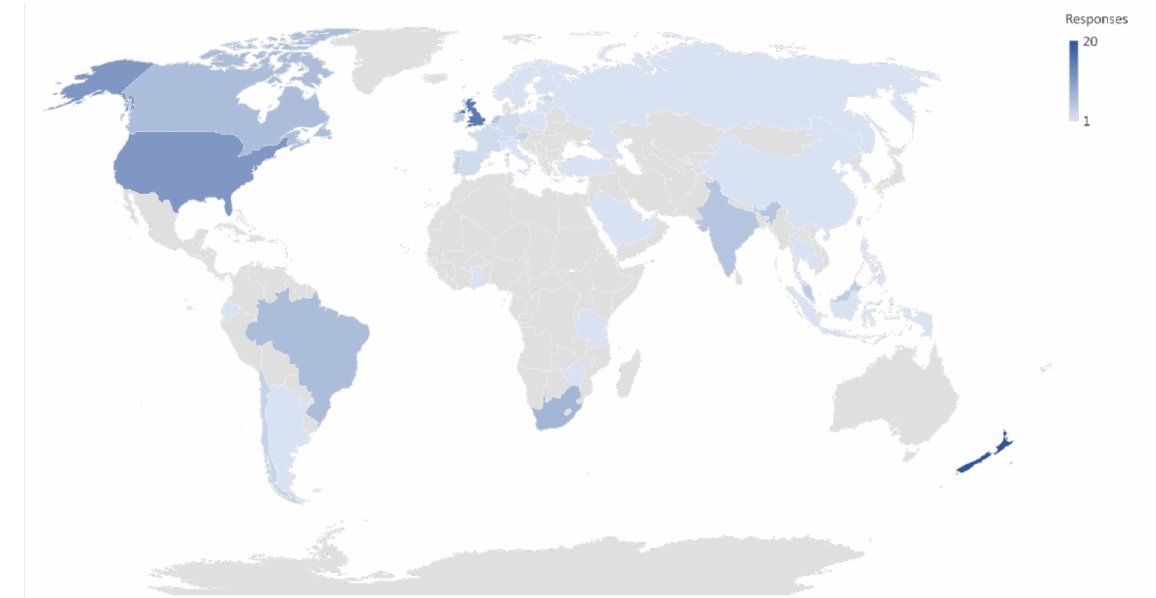
Figure 4. Global distribution of respondents outside